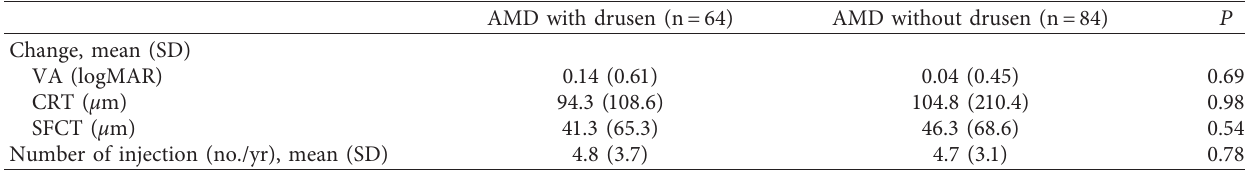
Table 3: Results of anti-VEGF therapy in nAMD including